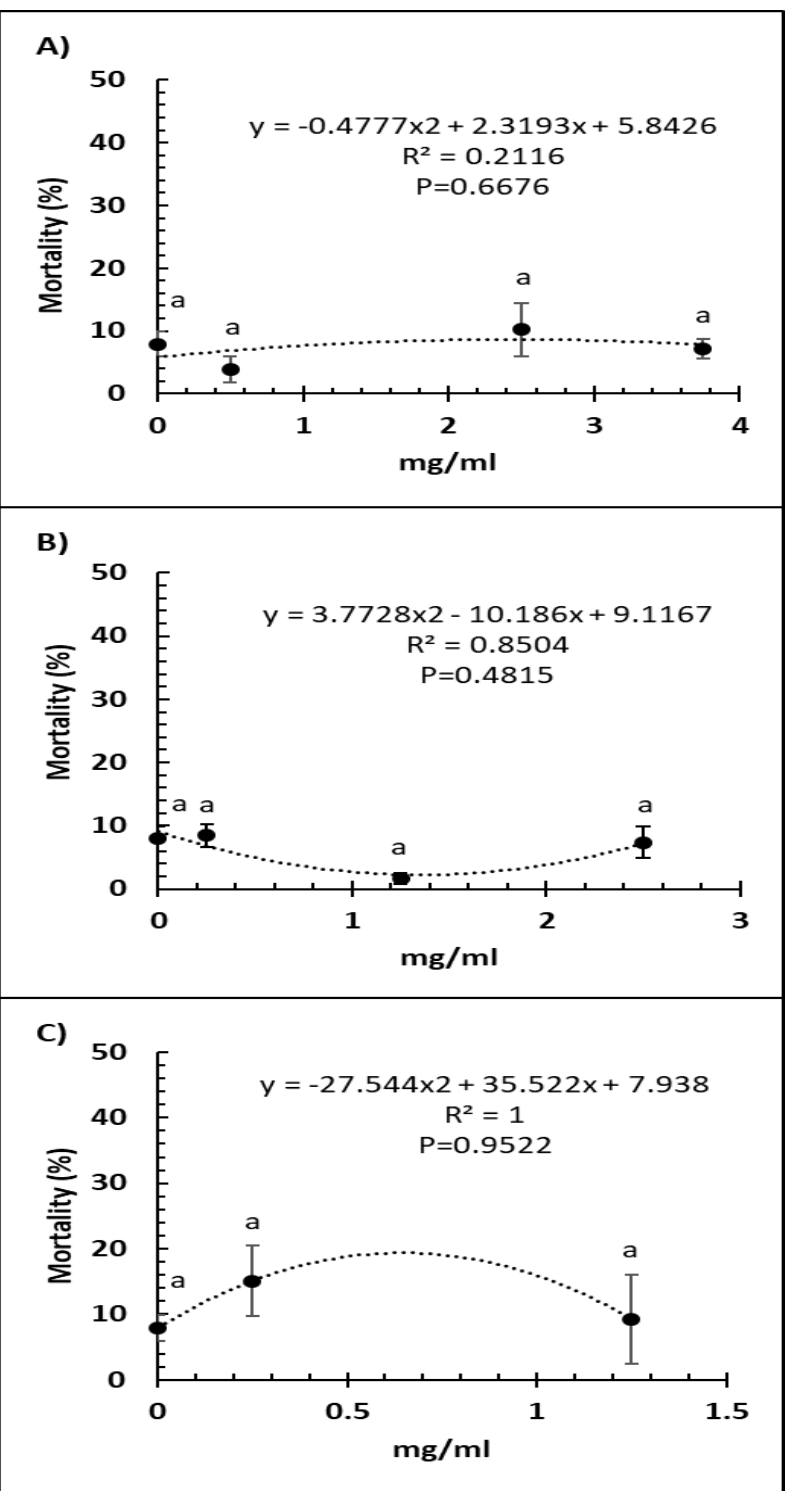
Figure 2. Relationship between percent bee mortality and concentration (mg/mL) of the probiotics Vetafarm Probotic ( A ), Protexin Concentrate single-strain ( B ), and Protexin Concentrate multi-strain ( C ), fed to N. ceranae -infected honey bees. Treatments followed by the same letter are not significantly different.